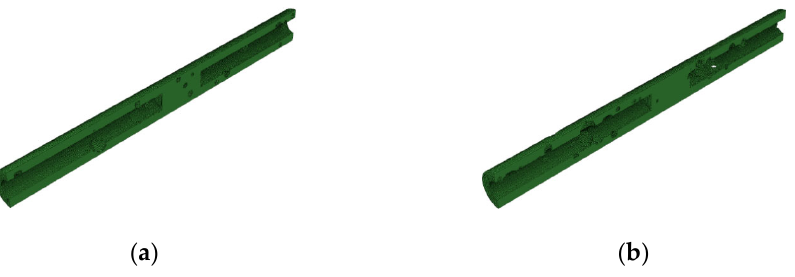
Figure 7. Diagrams of grouting defect meshes. ( a ) 5% grouting defects. ( b ) 10% grouting defects.